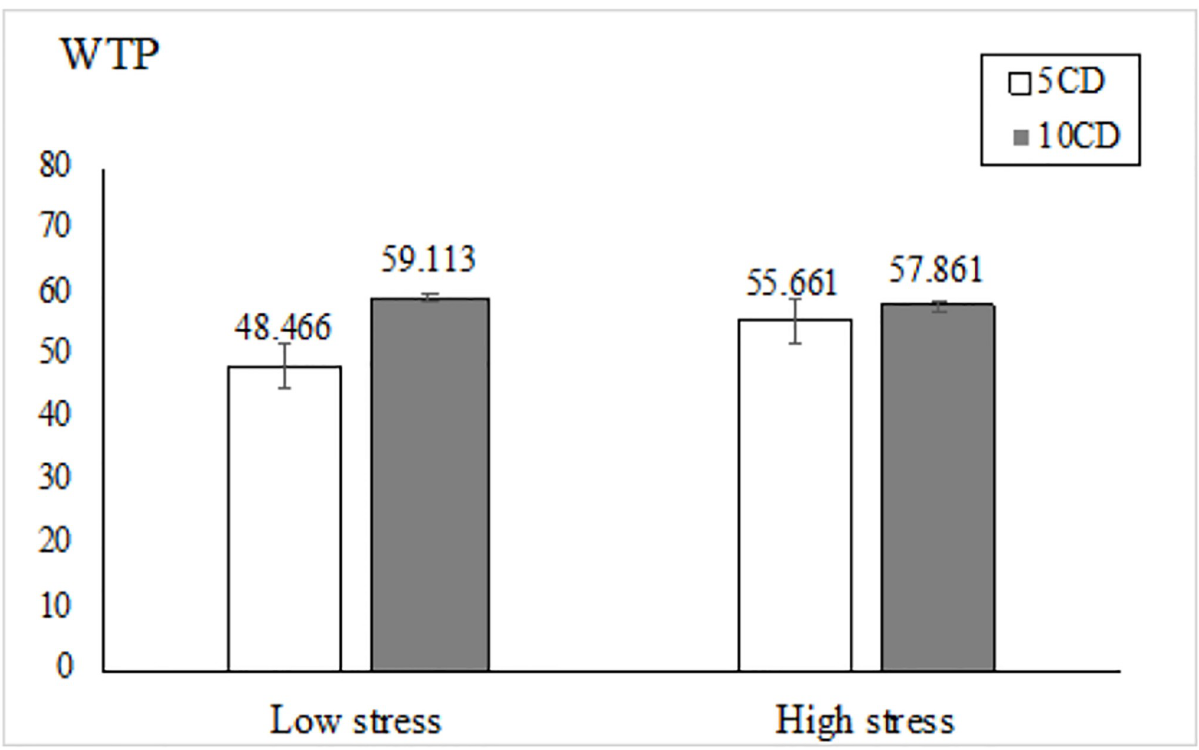
Fig 2. Stress and scope sensitivity in purchasing